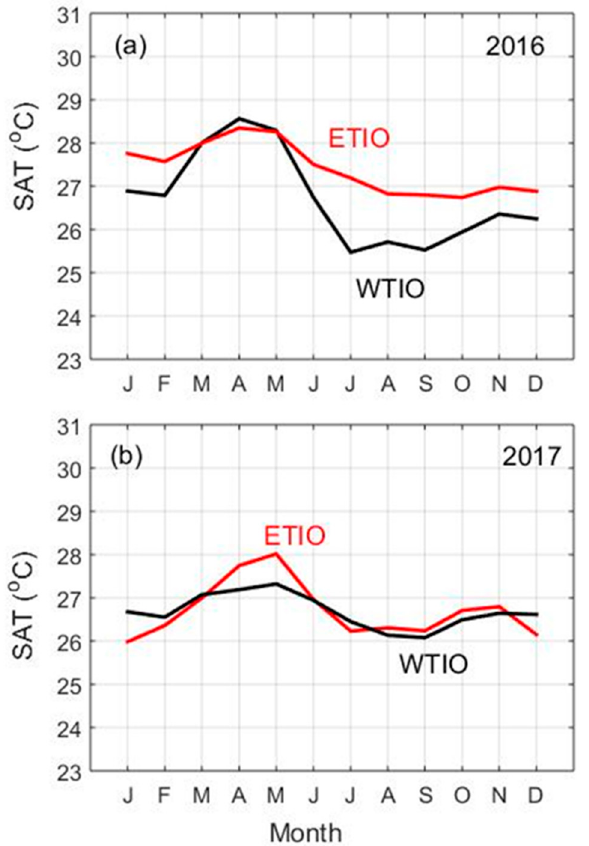
Figure 9. Monthly mean SAT variability at 1 atmospheric pressure in the equatorial tropical Indian Ocean in 2016 ( a ) and 2017 ( b ). Data provided by NCEP Global Data Assimilation System (GDAS) and available at 2.5° × 2.5° horizontal resolution.